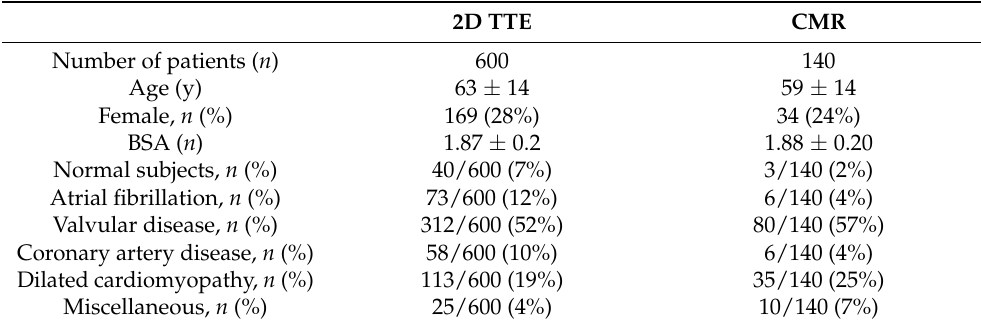
Table 1. Study population characteristics. TTE: transthoracic echocardiography; CMR: cardiac magnetic